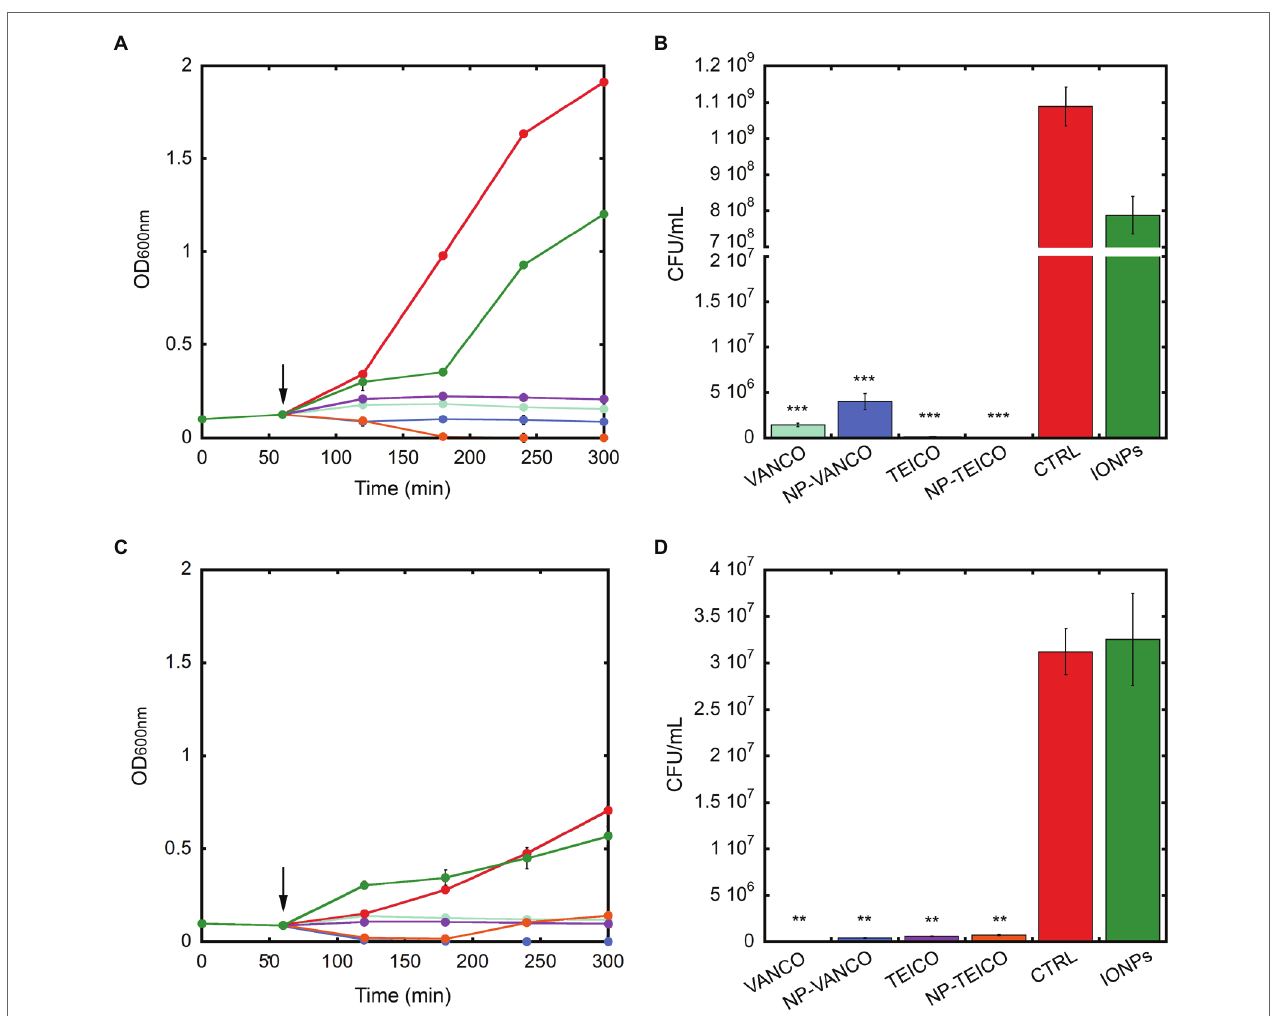
FIGURE 2 | Population growth kinetics of B. subtilis ATCC 6633 (panel A ) and S. aureus ATCC 25923 (panel C ) exposed to 0.4 mg/ml of IONPs (green), NP- VANCO (blue, corresponding to 84 μ g/ml of conjugated vancomycin), NP-TEICO (orange, corresponding to 61.5 μ g/ml of conjugated teicoplanin), or to nonconjugated teicoplanin (TEICO, violet) and vancomycin (VANCO, turquoise), supplemented at the concentrations of the corresponding nanoconjugated antibiotics loaded onto IONPs. Cultures without any addition (CTRL, red) were used as control. Black arrows indicate the addition (after 1 h) of IONPs, or nanoconjugated, or nonconjugated antibiotics to bacterial populations. In panels B and D , bacterial cell viability of B. subtilis ATCC 6633 and S. aureus ATCC 25923, respectively, measured as CFU/ml after 5-h growth. Experiments were conducted in triplicate for each condition. Statistical analyses were performed by one-way ANOVA (** p < 0.01; *** p <